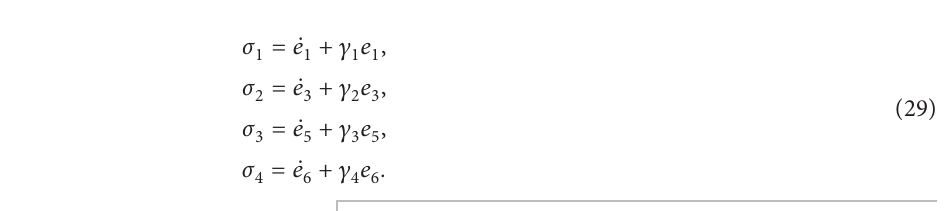
Figure 11: A dynamic sliding mode control of the asymptotically stable state regime at the Reynolds number R to periodic regime at R e � 24 in the master system (7). The controller is switched on at time t � 10. (a) The L ( t ) and y ( t ) versus time. (c) The states x (b) The states x 1 1 showing how the controller drives the states from one attractor to another